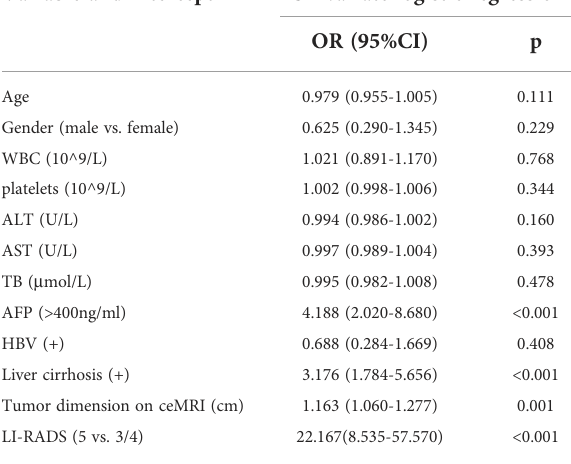
TABLE 2 Univariate logistic regression analyses for the prediction of VEGFR2-positive HCC.